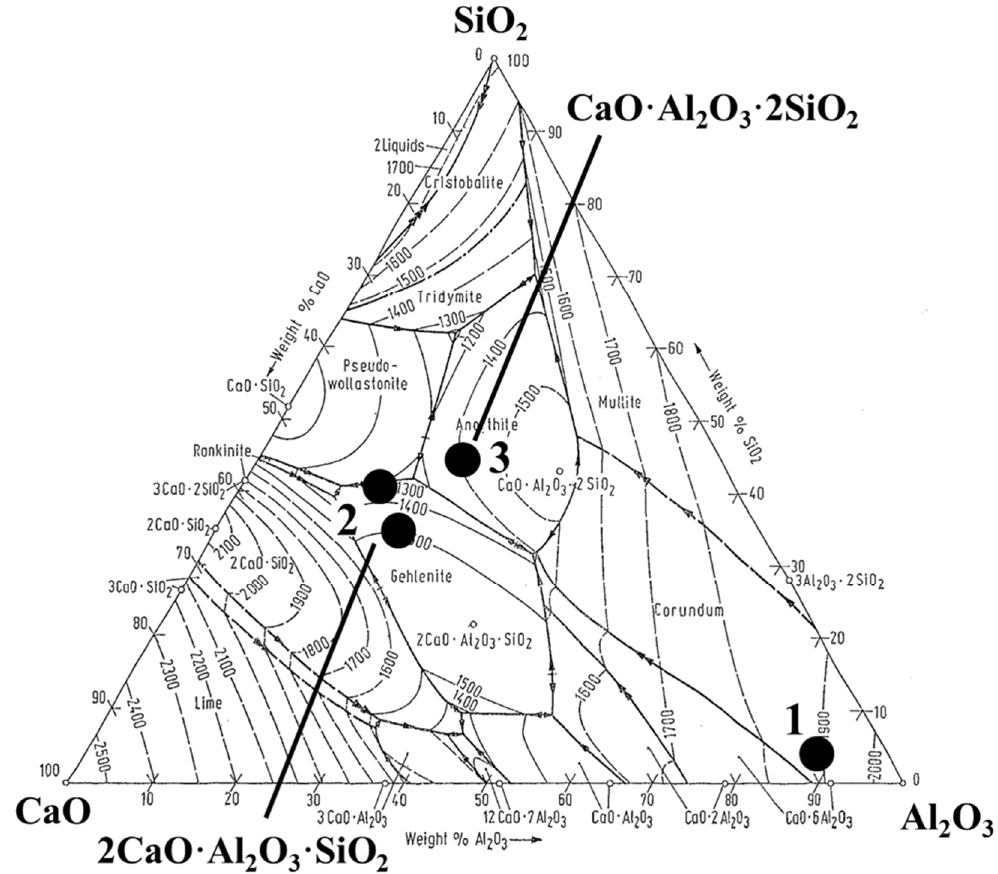
Figure 22. Typical compositions of oxide inclusions observed in experimental trials of AISI 316L stainless steel [42].